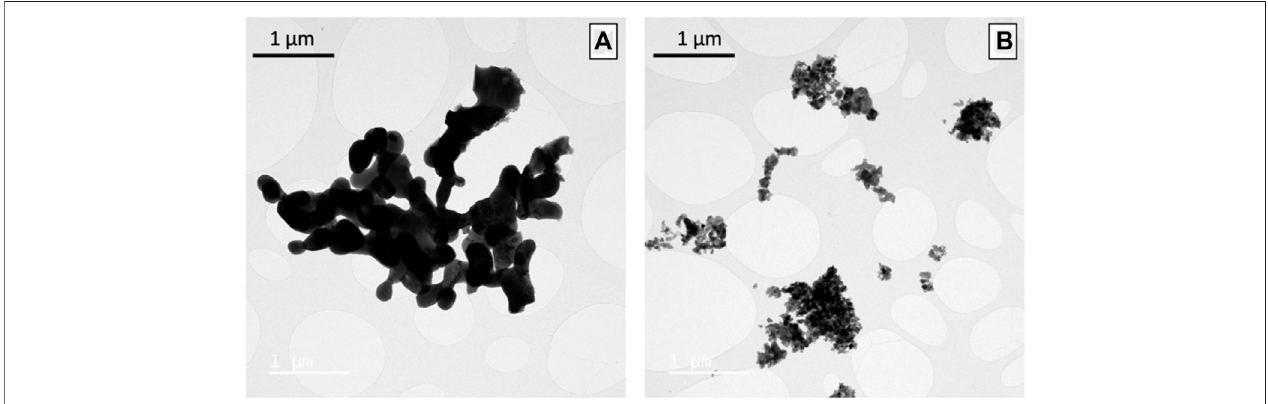
FIGURE2| TEMimagesof (A) AgNbO 3 and (B) Ag 0.70 La 0.10 □ 0.20 NbO 3 afterannealingat650 ° Cshowingthedifferenceinparticlessizebetweenunsubstitutedand substituted oxides.